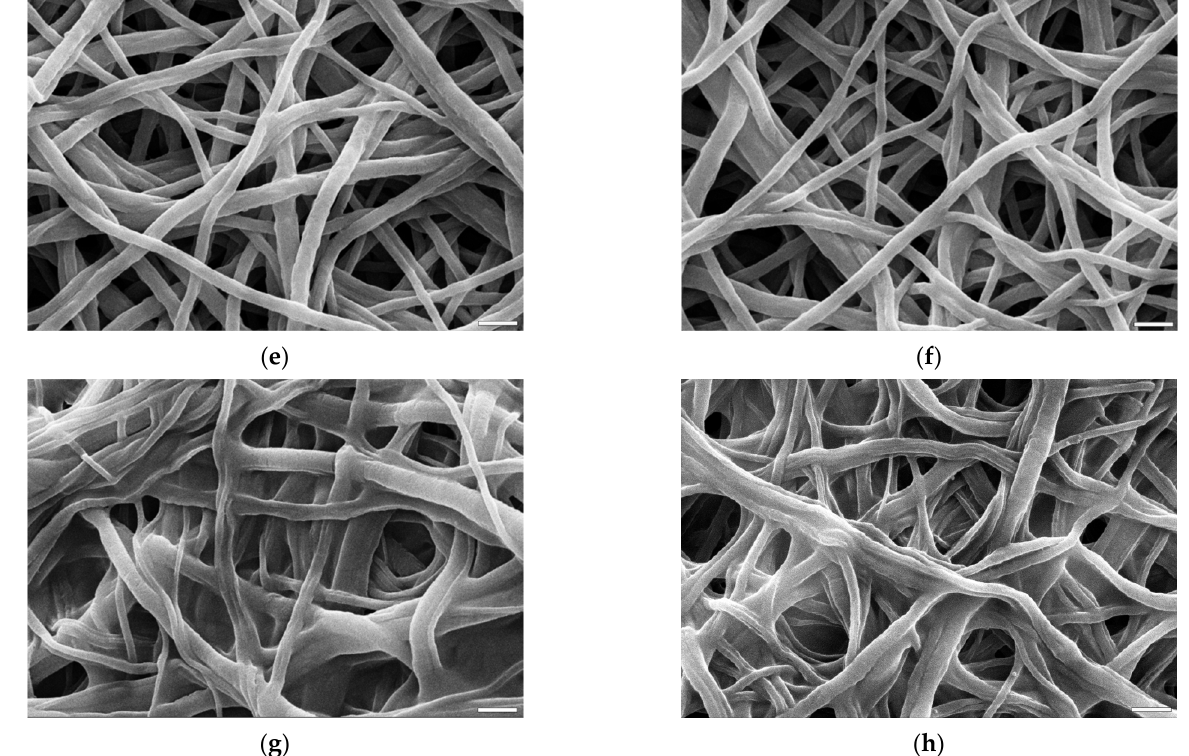
Figure 9. SEM images of samples crosslinked with different methods: before (left) and after (right) 24 h of biodegradation test: ( a , b ) transglutaminase 40 U/mL, 24 h, ( c , d ) genipin 4%, 48 h, ( e , f ) EDC/NHS 0.12%/0.04%, 40 min, ( g , h ) BDDGE 10%, 48 h. The marker equals 10 µm.